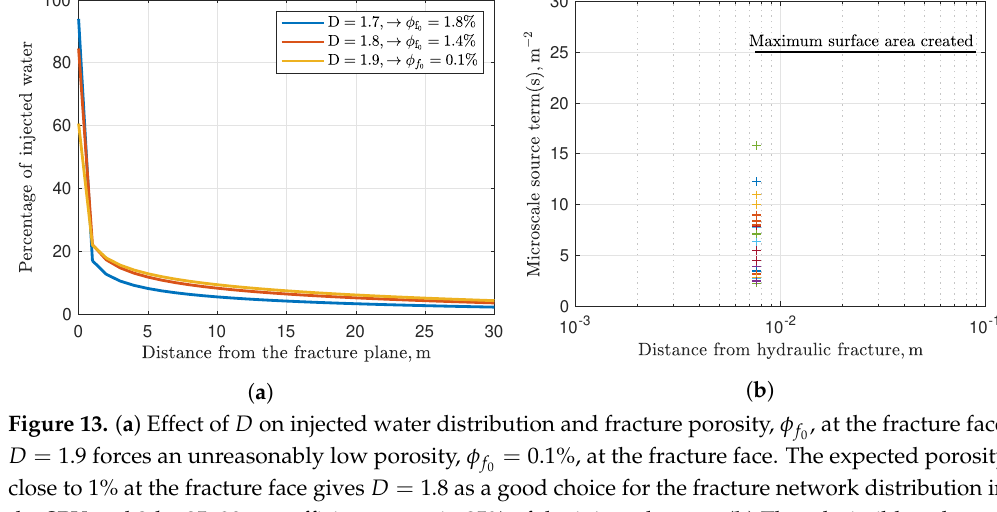
Figure 13. ( a ) Effect of D on injected water distribution and fracture porosity, φ f , at the fracture face. 0 = 0.1%, at the fracture face. The expected porosity D = 1.9 forces an unreasonably low porosity, φ f 0 close to 1% at the fracture face gives D = 1.8 as a good choice for the fracture network distribution in the SRV and 2 d = 85–90 m, sufficient to retain 85% of the injected water. ( b ) The admissible values of the source term, s , for the simulated wells are limited by the maximum depicted as the continuous line at the fracture face. This upper bound helps in constraining the values of s obtained from optimization. A low value of s from the simulation means that only a small part of the stimulated surface is connected well enough for efficient gas